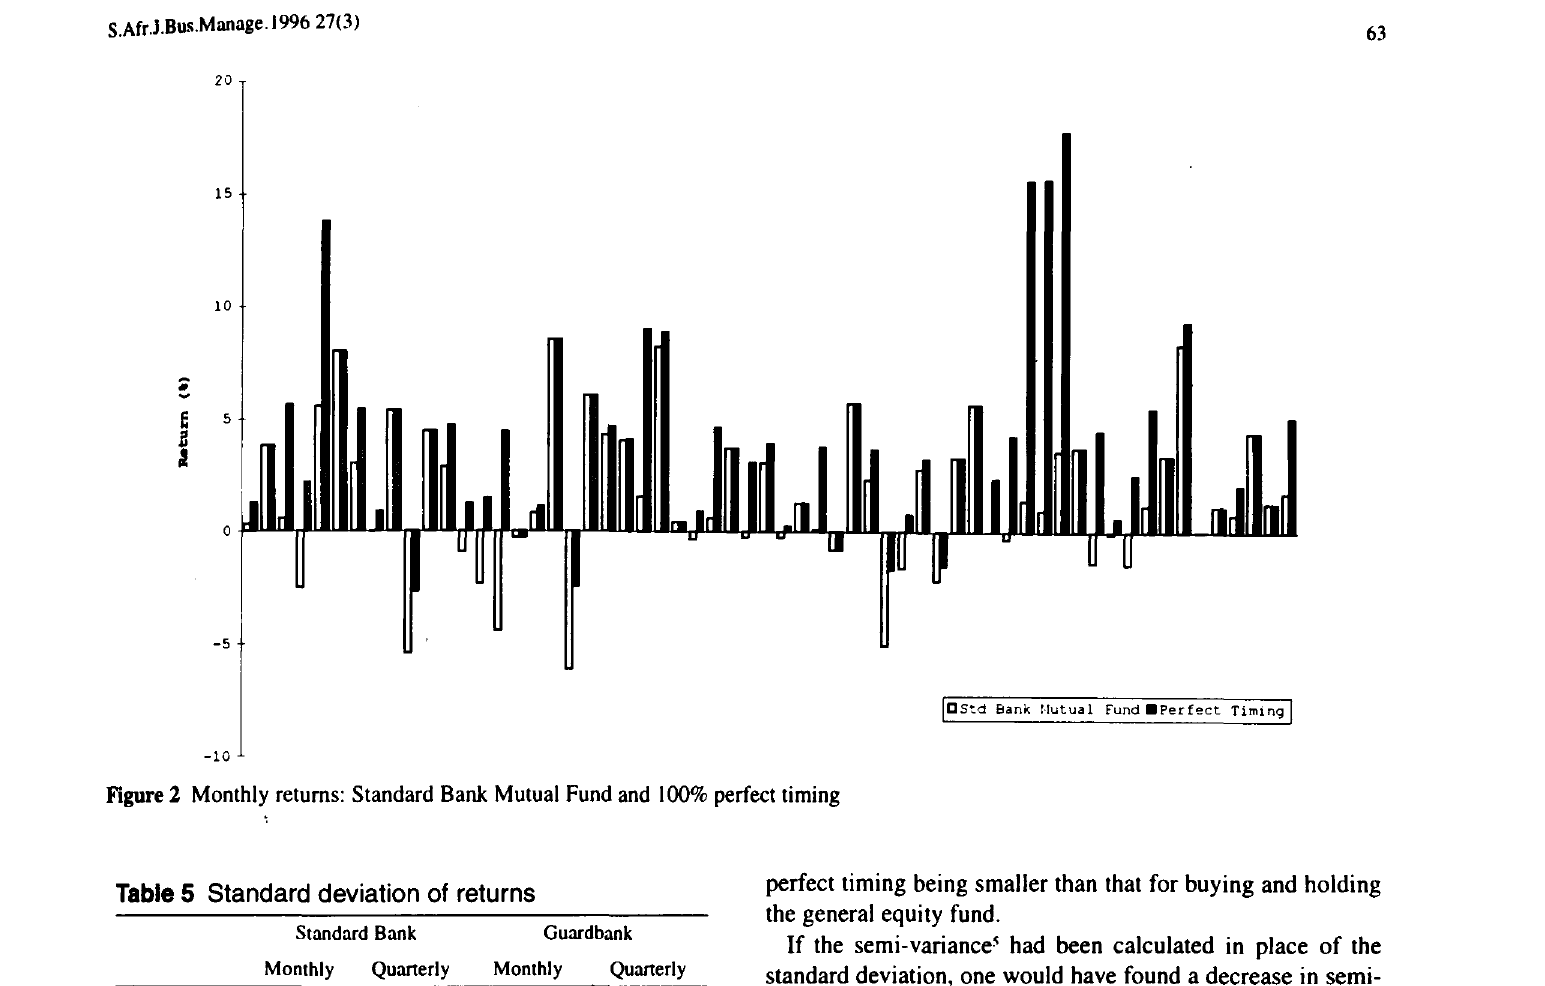
Table 5 Standard deviation of returns Standard